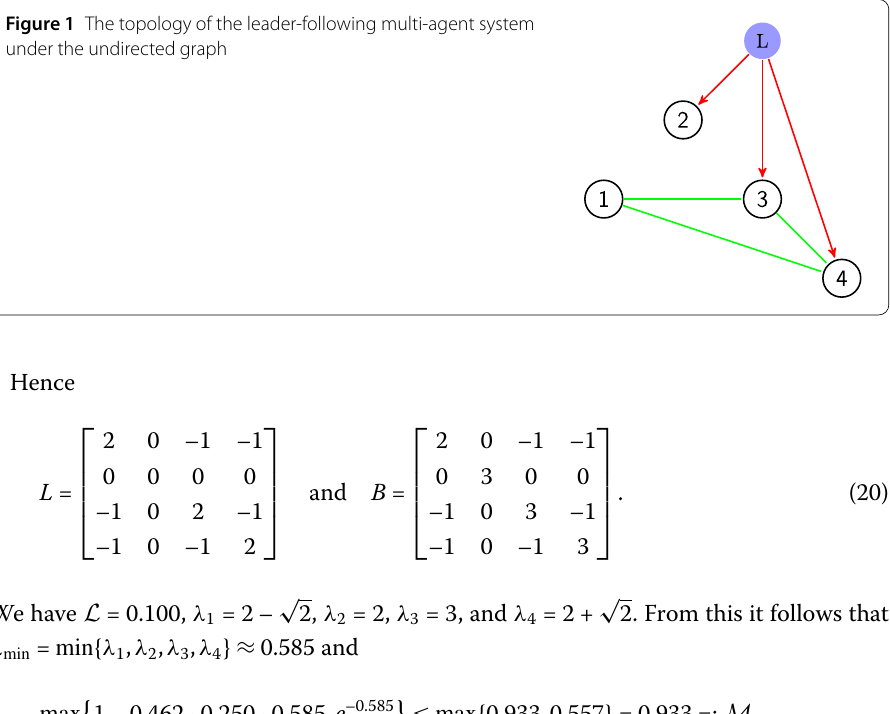
Figure 1 The topology of the leader-following multi-agent system under the undirected